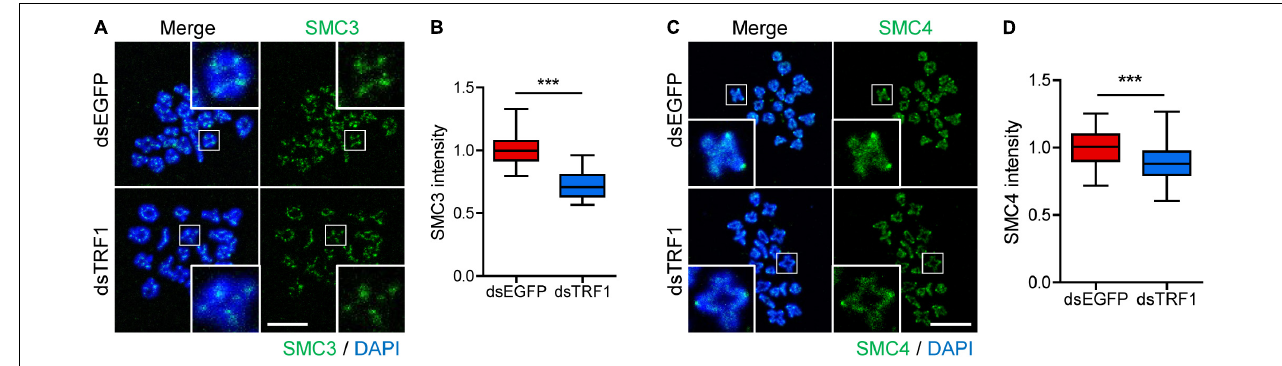
FIGURE 4 | TRF1 is associated with chromosome condensation and cohesion. (A–D) Chromosome spreads were prepared from oocytes at the MI stage and were stained with anti-SMC3 and anti-SMC4 antibodies. DNA was counterstained with DAPI. The normalized intensity of SMC3 and SMC4 was quantified and shown with the representative images (scale bar, 20 µ m). *** p <